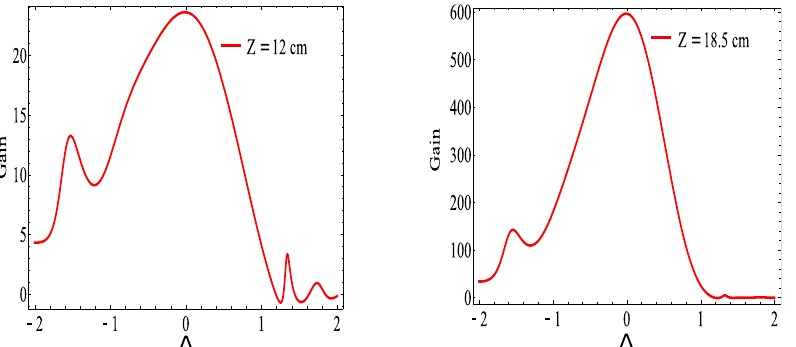
Figure 13. Gain vs. the normalized detuning ∆ at different z-position for the ω − resonance calculated using the analytical solution in the SSA regime with the parameters reported in Table